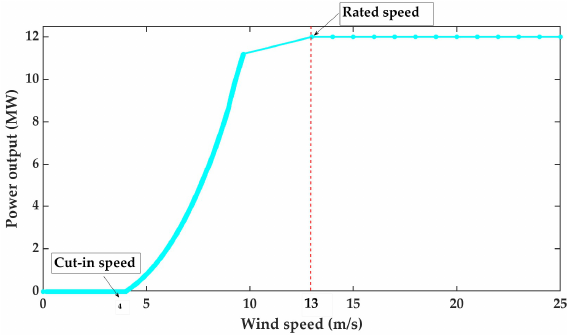
Figure 4. Power output curve used for the research.